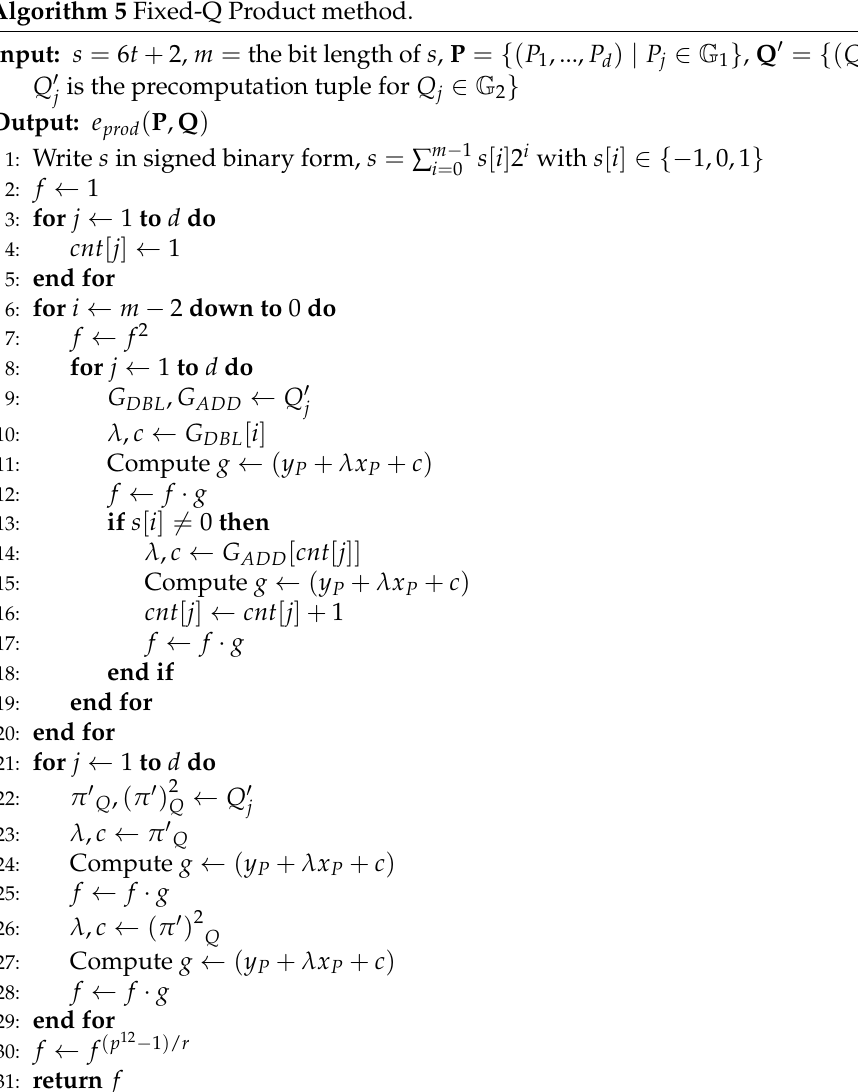
Algorithm 5 Fixed-Q Product